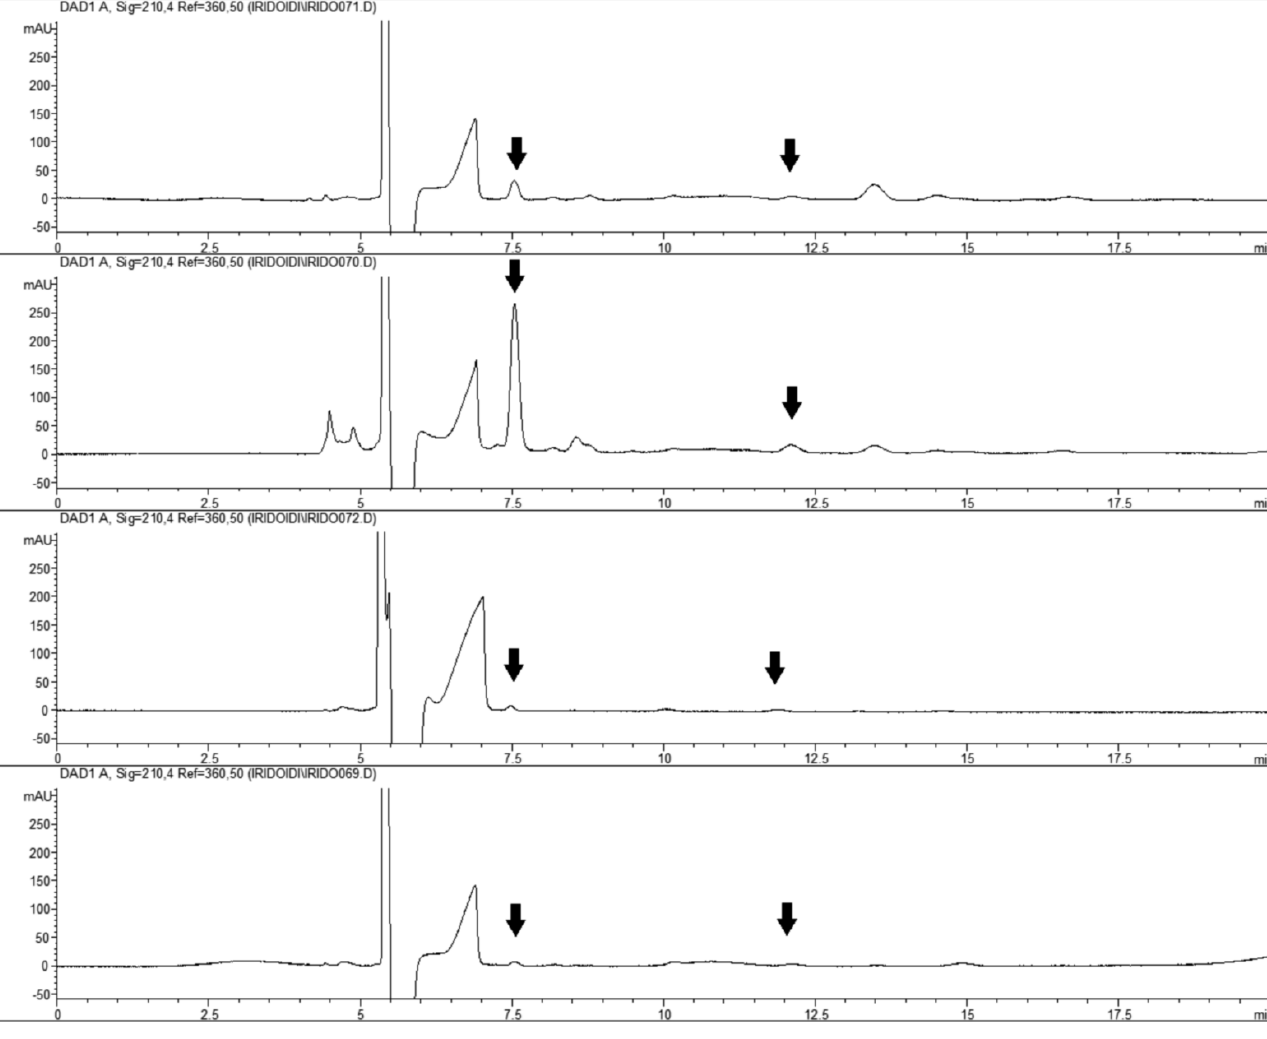
Fig. 1: Chromatograms of G. punctata leaves, flowers, woody stems and underground parts obtained by diode array detector (arrows indicating the presence of catalpol and aucubin,